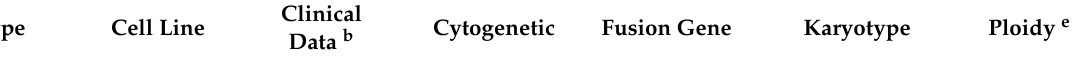
Table 1. MLL -rearranged and non- MLL -rearranged leukemia cell lines a Cell lines obtained from the German Collection of Microorganisms and Cell Cultures (DSMZ) public repository (see https: //www.dsmz.de, accessed on 16 October 2022). b Clinical data as reported at the DSMZ and in the literature: type of disease, age (years)/sex, source of material from which cell line was established [50]. c Cytogenetic analysis at the DSMZ confirmed the chromosomal abnormality. d RT-PCR at the DSMZ showed the expression of the fusion gene. (*) Karyotype provided by Giovanni Giudici (Centro Ricerca Tettamanti, Clinica Pediatrica Universit à Milano-Bicocca, Ospedale S. Gerardo, Monza, Italy). Abbreviations: ALL, acute lymphoblastic leukemia; AML, acute myeloid leukemia; APL,